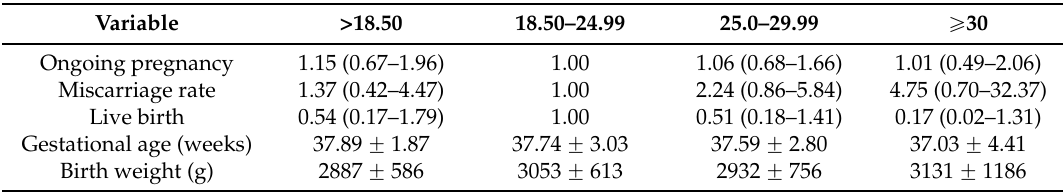
Table 3. Pregnancy outcomes by female